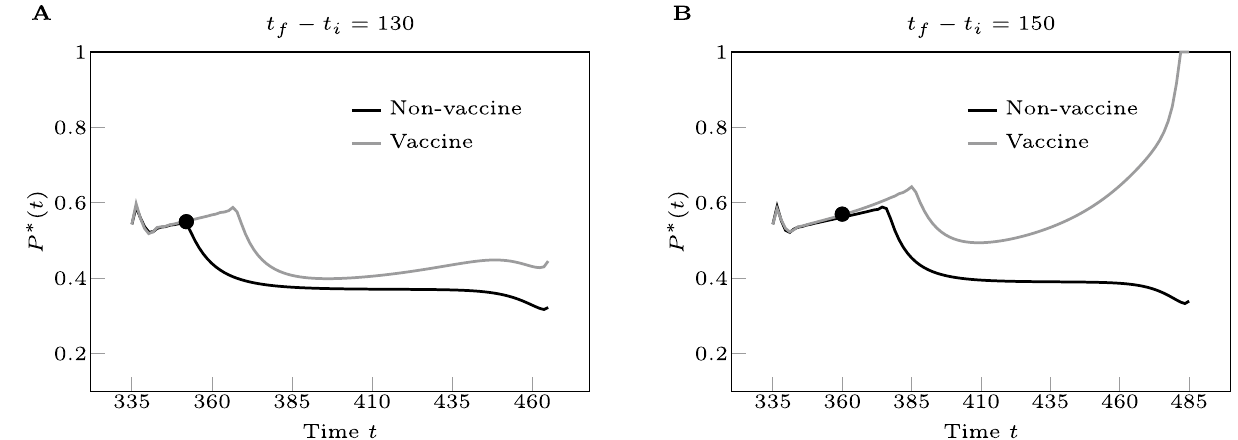
Figure 7. Effects of vaccinations on the optimal control solution. We consider the Seattle Metropolitan Statistical Area. In A the control horizon T cont = ( t f − t i ) = 130 days and in B the control horizon T cont = ( t f − t i ) = 150 days. For both figures, we plot P ∗ ( t ) by comparing the two cases that the model includes the effects of vaccination (gray curve) or does not (black curve.) The full black dot indicates the point in time at which the two curves depart from each other. As can be seen, the separation between the two curves appears to be much larger over a longer control horizon. The plot on the right shows the parameter P ∗ ( t ) approach 1 at the end of the control horizon, which corresponds to removal of the social distancing measures. Additional plots showing the time evolutions of the states corresponding to the optimal solutions in ( A ) and ( B ) can be found in the Supplementary Information, Note 11.